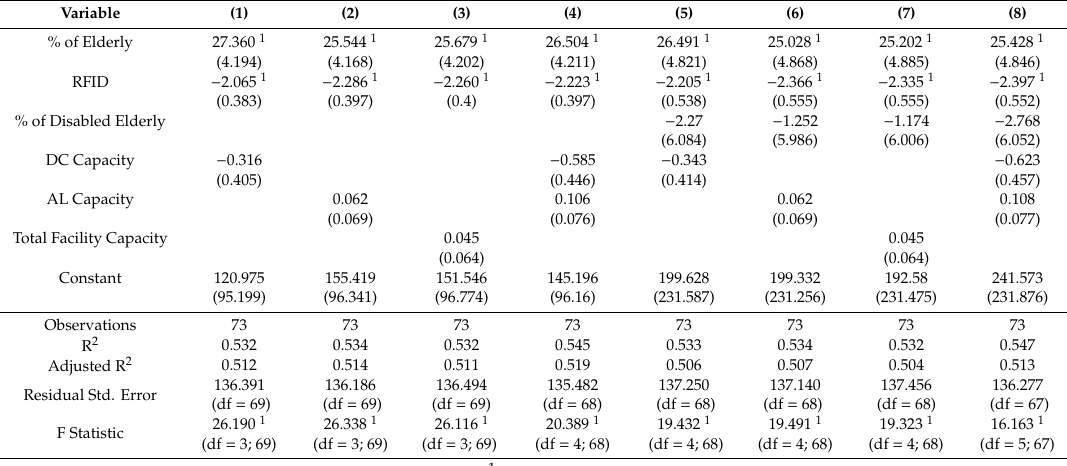
Table 5. Regression analysis for the cases per 100,000 residents in Barcelona by neighborhood until 20 July 2020 (standard errors are displayed in parenthesis under the coe ffi cient estimates, n = 73 neighborhoods).